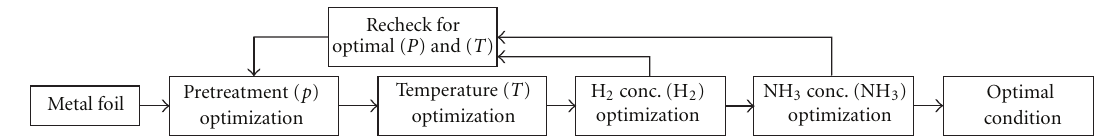
Figure 3: Univariant optimization experimental design for CNF